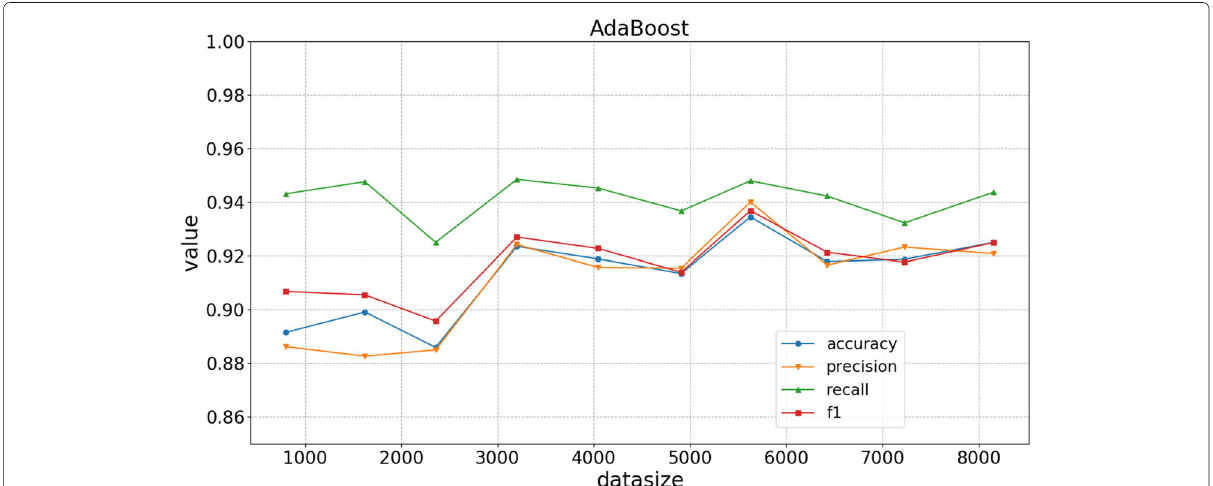
Fig. 13 Result of AB with different training set size. We test the AdaBoost Decision Tree classifier using subsets with the following sizes: 803, 1622, 2357, 3201, 4043, 4909, 5628, 6425, 7230, and 8155, where the ratio of positive/negative is close to 1. The accuracy is high, which is above 95%. With the increase of the data size, the results get better